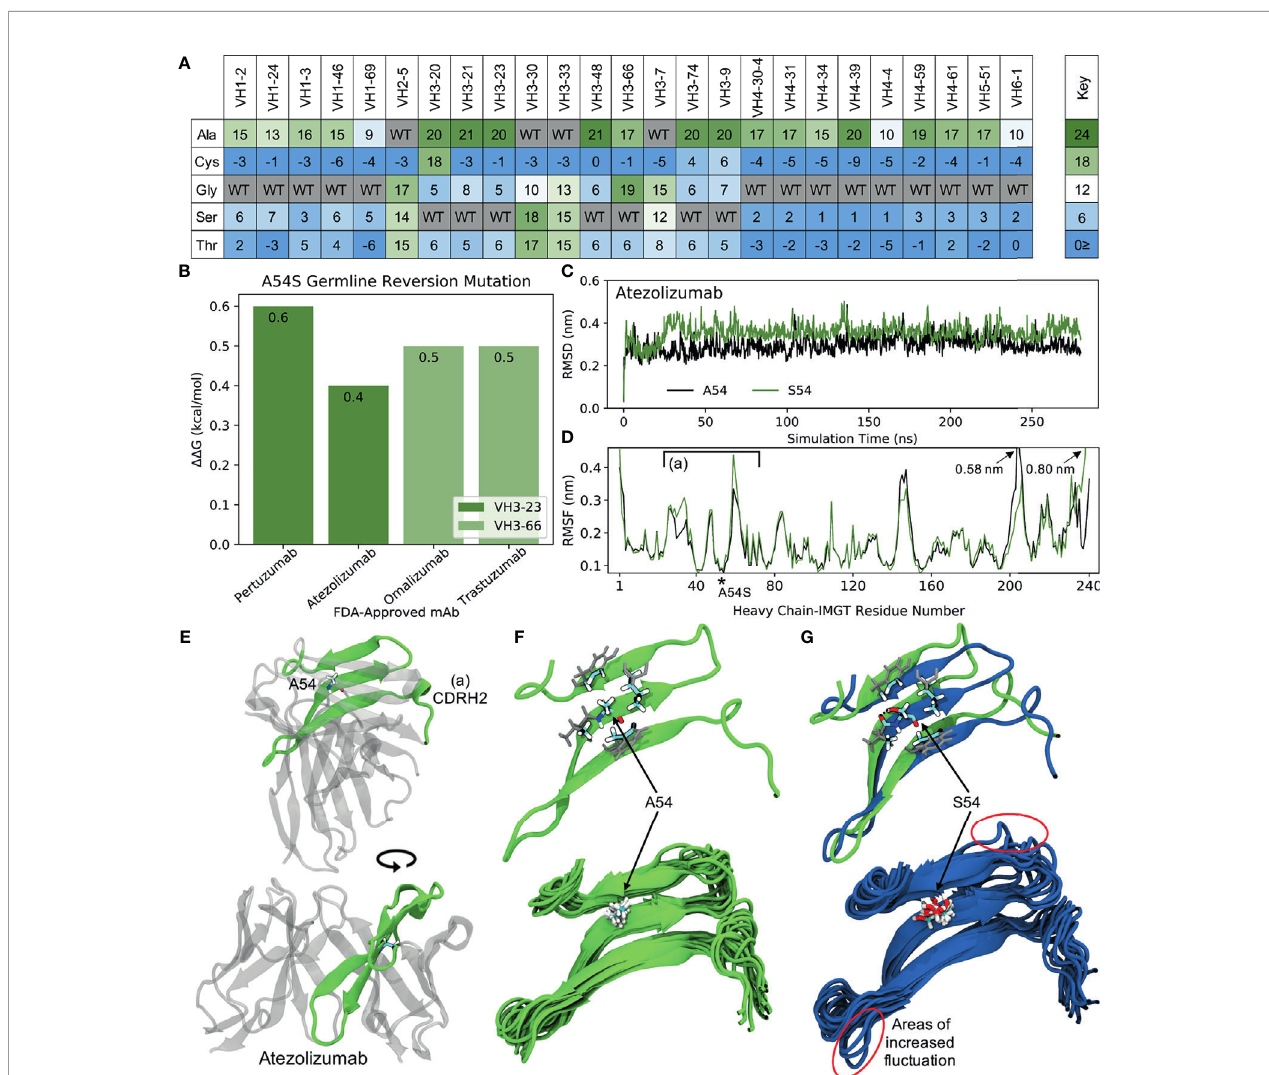
FIGURE 7 | Molecular dynamics (MD) simulations indicate the ‘ universal ’ FR mutation S54A improves mAb stability. (A) Heatmap of FR scores for the mutation of residue 54 to different amino acids for each of the 25 germline genes. (B) Change in stability as predicted by PremPS upon introducing the A54S germline-reverted mutation into the sequences of four FDA-approved mAbs from two different germlines. (C) Root mean square deviation (RMSD) of Atezolizumab with and without the germline-reverted mutation A54S, referenced to the respective energy-minimized structures, as a function of MD simulation time. (D) Root mean square fl uctuation (RMSF) of individual residues in Atezolizumab with and without the A54S mutation, calculated from the MD trajectories. (E) Energy-minimized structure of Atezolizumab in white, with regions in green indicating residues that experienced relatively large fl uctuations in the MD simulations, as indicated in (D) by square brackets. (F) Zoomed-in view of region-of-interest (A) from panels (D, E) , showing the favorable hydrophobic binding pocket of A54 in Atezolizumab (top) and the stability of surrounding loop regions (bottom; 15 overlaid snapshots, equally spaced across the entire trajectory). (G) MD simulation snapshot of Atezolizumab with (blue) and without (green) the germline-reverted mutation A54S, highlighting differences in local secondary structure (top) and relatively large fl uctuations in surrounding loops (bottom). A black dashed line indicates a hydrogen